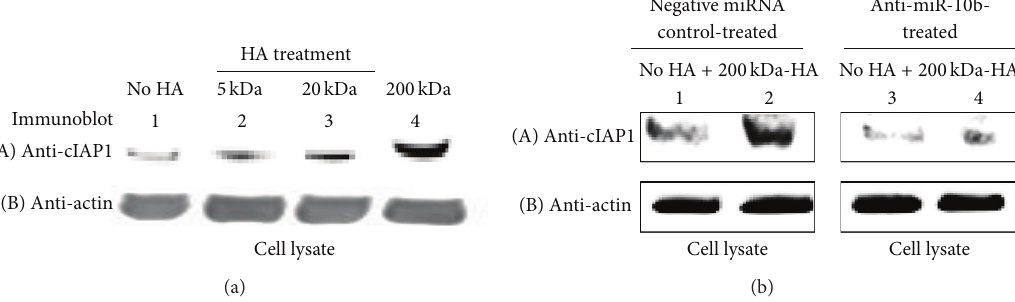
Figure 6: Analyses of 200 kDa-HA-mediated survival protein (cIAP1) expression in CD 44 v 3 high ALDH high cells. (a) Detection of the expression of cIAP1 by anti-cIAP1-mediated immunoblotting using cell lysate isolated from CD 44 v 3 high ALDH high cells treated with different sizes of HA [e.g., no HA ((A), lane 1), 5 kDa-HA ((A), lane 2), 20 kDa-HA ((A), lane 3), and 200 kDa-HA ((A), lane 4)] for 3 days. (b) Detection of the expression of cIAP1 by anti-cIAP1-mediated immunoblotting using cell lysate isolated from CD 44 v 3 high ALDH high cells transfected with negative miRNA control [treated with no HA ((A), lane 1) or with 200 kDa-HA for 24 h ((A), lane 2)] or treated with anti-miR-10b inhibitor with no HA ((A), lane 3) or with 200 kDa HA addition for 3 days ((A), lane 4). The amount of actin detected by anti-actin-mediated immunoblot ((a): (B), lane 1–4; (b): (B), lane 1–4) in each gel lane was used as a loading